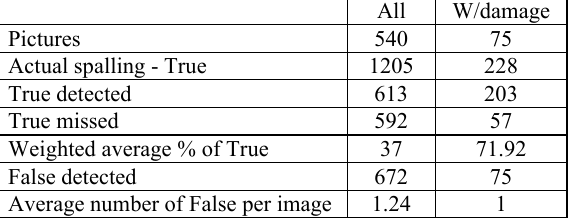
Table 1 - Truth table of the detected and missed